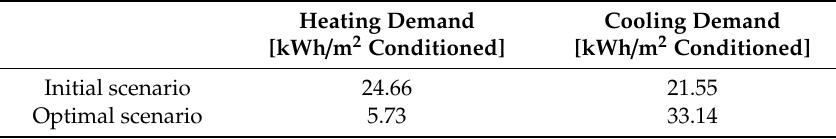
Table 7. Comparison between the initial situation of the building and the optimal heating